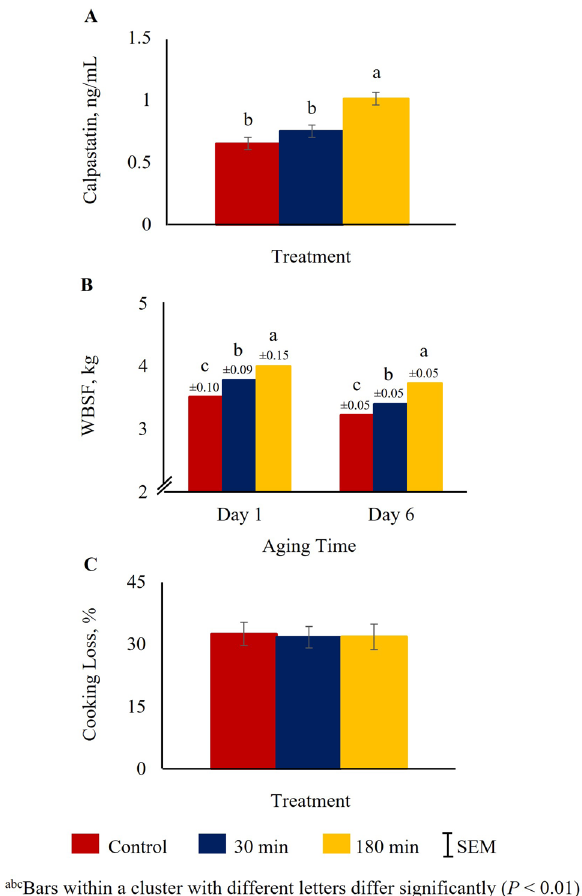
Figure 3. Effects of stress treatment (Control = not transported but held in pens; 30 min = transported for 30 min; 180 min = transported for 180 min) on mean ± SEM loin/rib ( Longissimus dorsi ) chop ( A ) calpastatin activity (24 h postmortem), ( B ) Warner–Bratzler shear force value (day 1 and day 6 of aging), and ( C ) cooking loss percentage (24 h postmortem) in